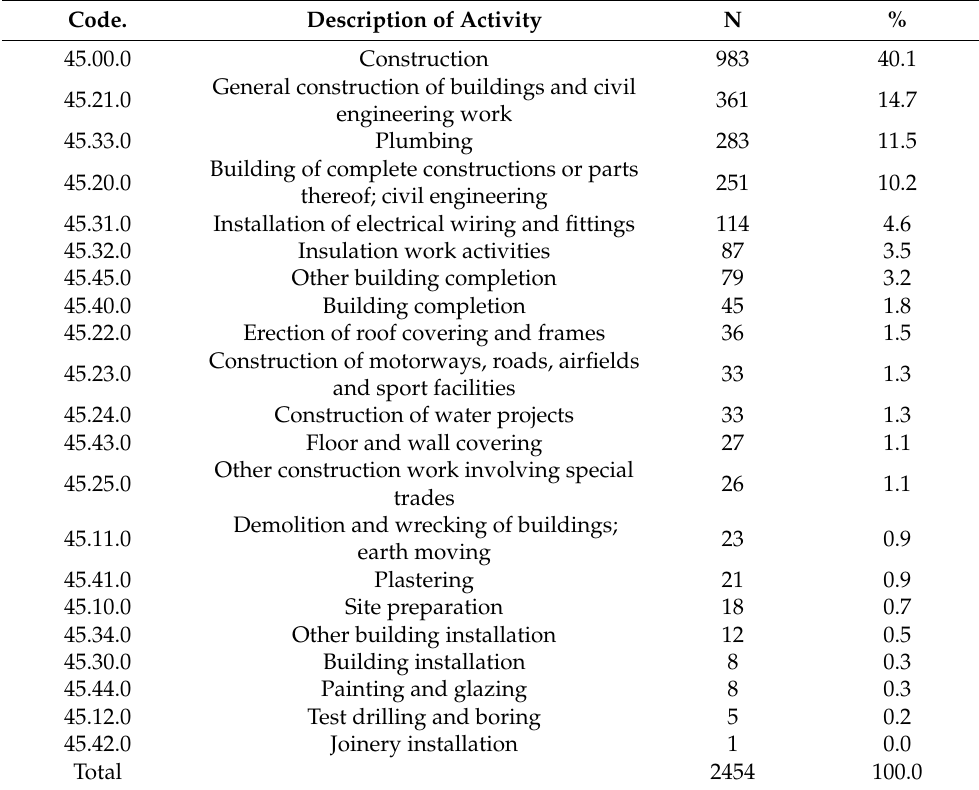
Table 3. Occurrences of exposures by economic activity (subjects exclusively exposed in the construc- tion sector and carrying out even more than one